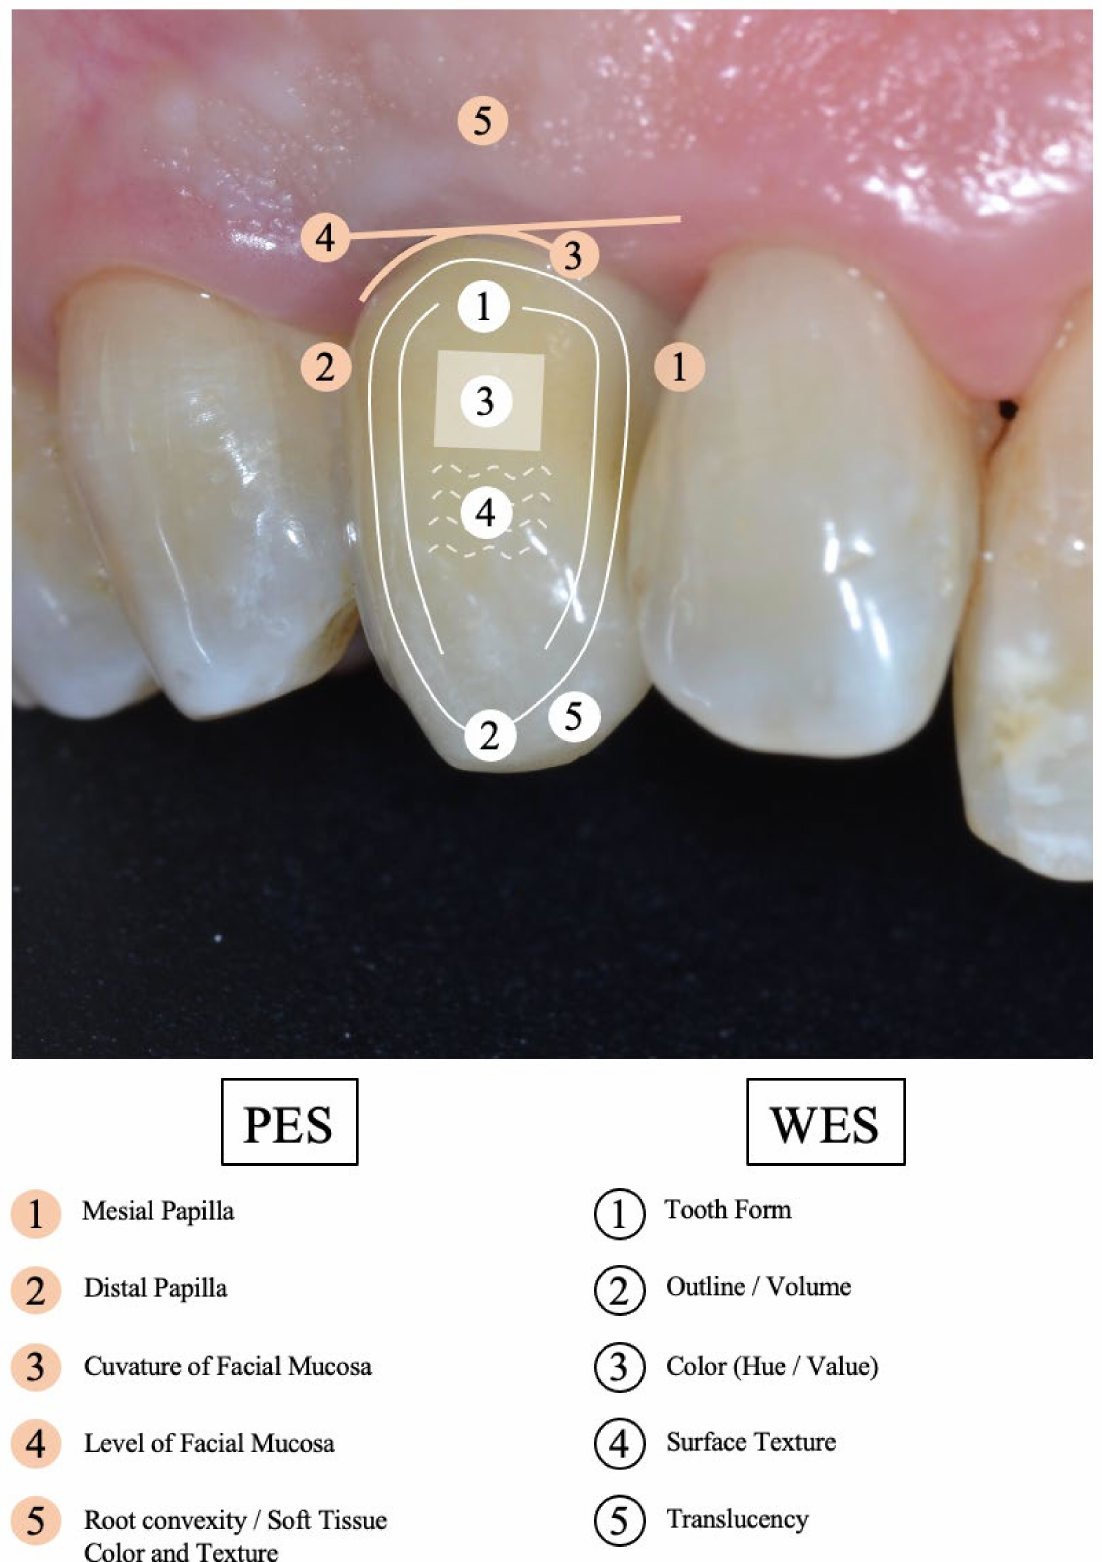
Figure 3. Clinical photograph of an implant of the platform matching group with detailed description of parameters evaluated for the Pink and White Esthetic